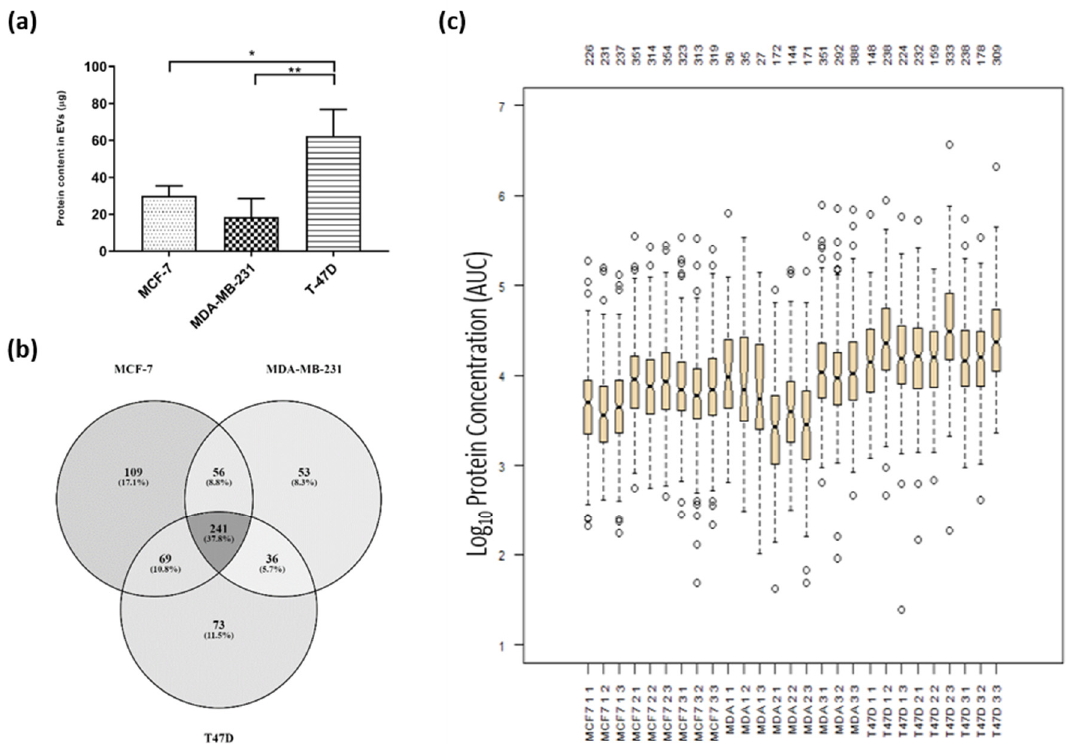
Figure 3. The variation between the EV proteomes across replicates and cell types. ( a ) Protein concentration of the cell-line-derived EVs using the Qubit protein assay. Data represents mean ± SD * p < 0.05, ** p < 0.01. ( b ) Venn diagram of proteins detected within EV derived from cancer cell lines. 900 proteins were detected in total with a high confidence level, having two reliable peptides or more or being identified with the same mass and retention time from the MS-1 scans. ( c ) The log 10 of the concentration (area under the curve (AUC)) of each of the proteins are plotted in their quartiles. The number of proteins detected within each sample is shown at the top of the plot. Box and whiskers plot show the relatively small variance between the technical replicates, and the large variance between the cell of origin of the EVs. The boxplot was generated using DanteR software.